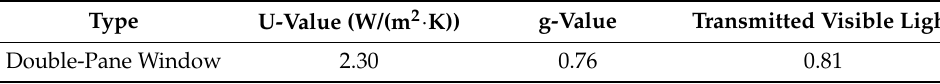
Table 3. Detailed properties of window.